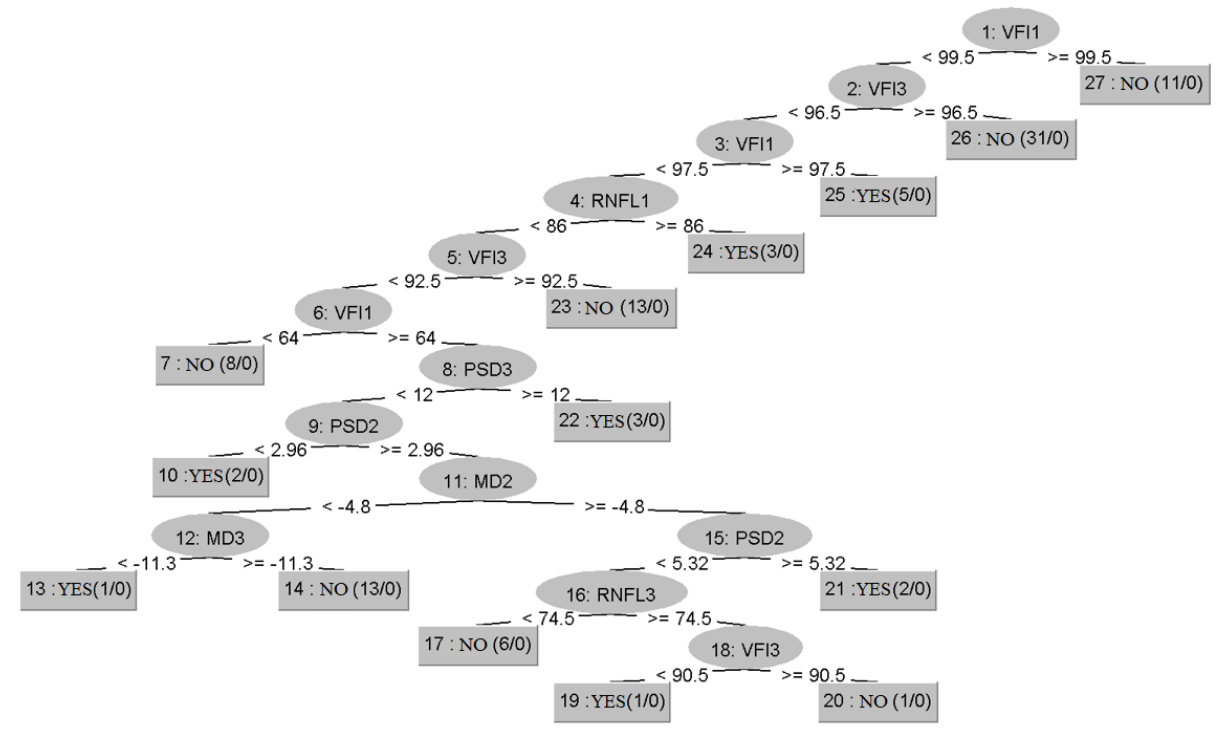
Figure 4. Decision tree generated by the Random Tree algorithm.